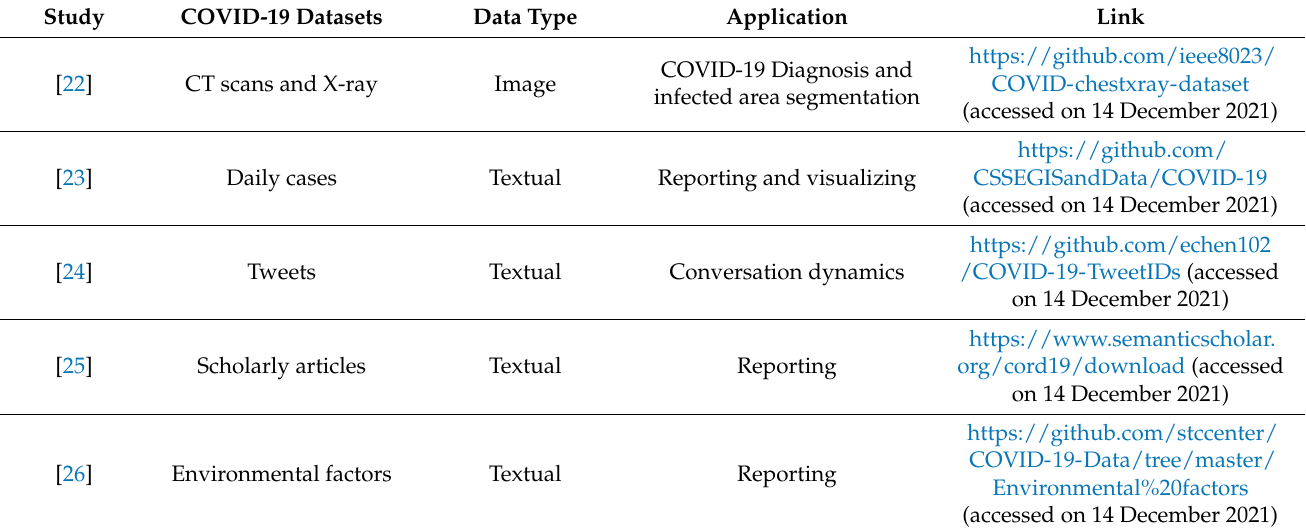
Table 2. COVID-19 open-source